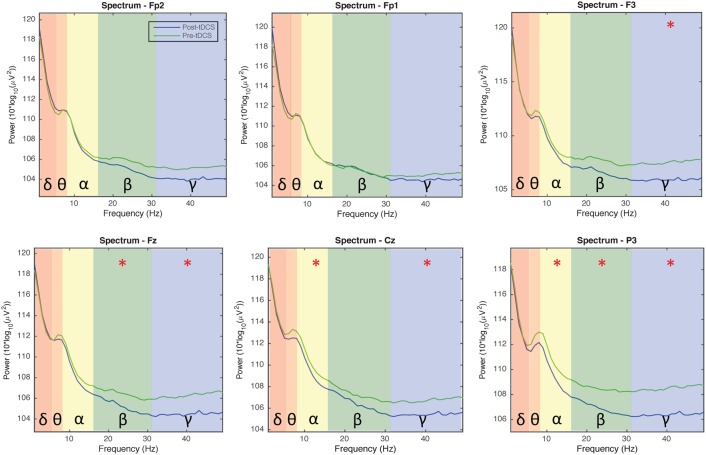
EEG power spectra analysis results comparison for all channels before and immediately after tDCS stimulation (1 - 50 Hz; Fp1, Fp2, Fz, F3, Cz, and P3; average of week 2, 3, and 7). The background colors indicate EEG frequency bands: red, δ wave; orange, θ wave; yellow, α wave; green, β wave; blue, γ wave. The green and blue lines, respectively, indicate power spectra before and after tDCS stimulation. Generally the power decreased immediately after tDCS stimulation for α, β, and γ waves.